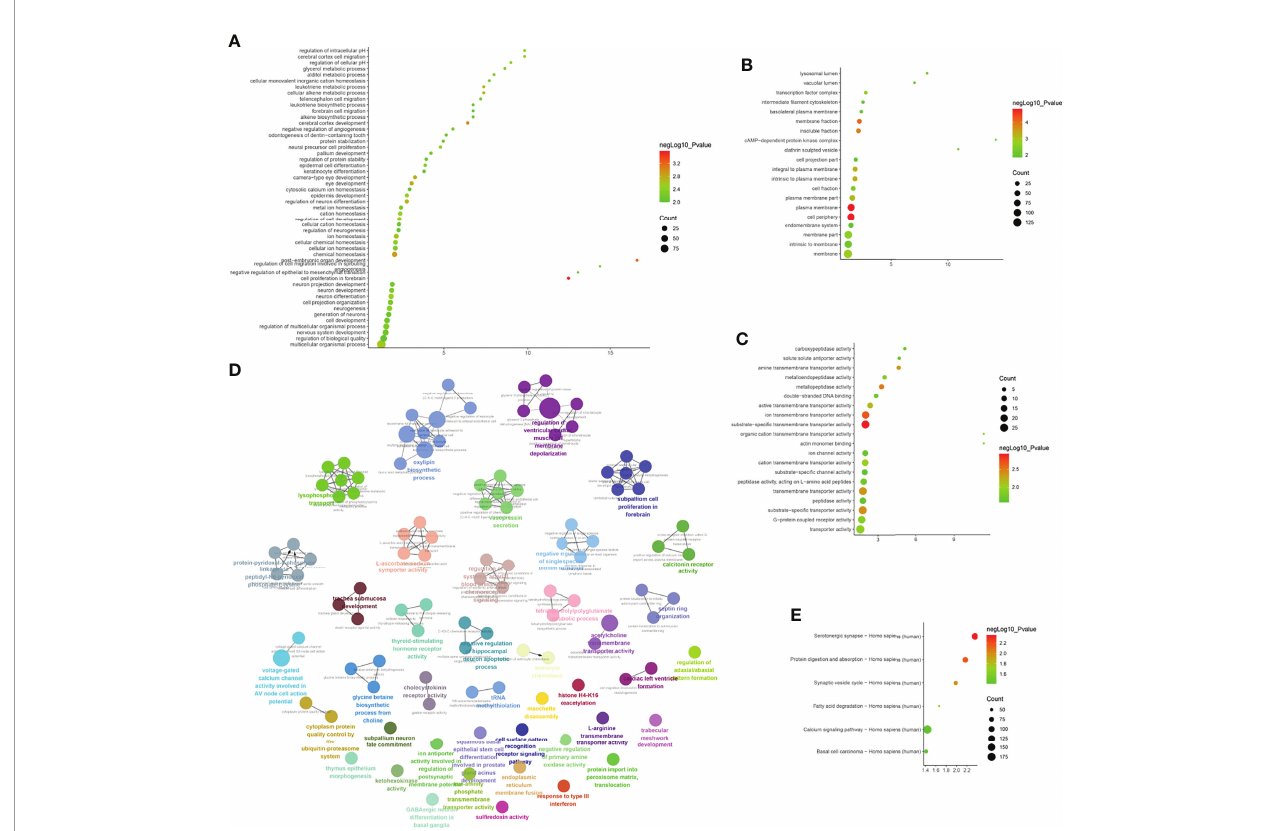
FIGURE 4 | Enrichment Analysis of up-regulated mRNA [ (A) biological processes; (B) cell components; (C) molecular functions; X-axis stands for fold enrichment. (D) enrichment results; (E) signaling pathways; X-axis stands for enrichment